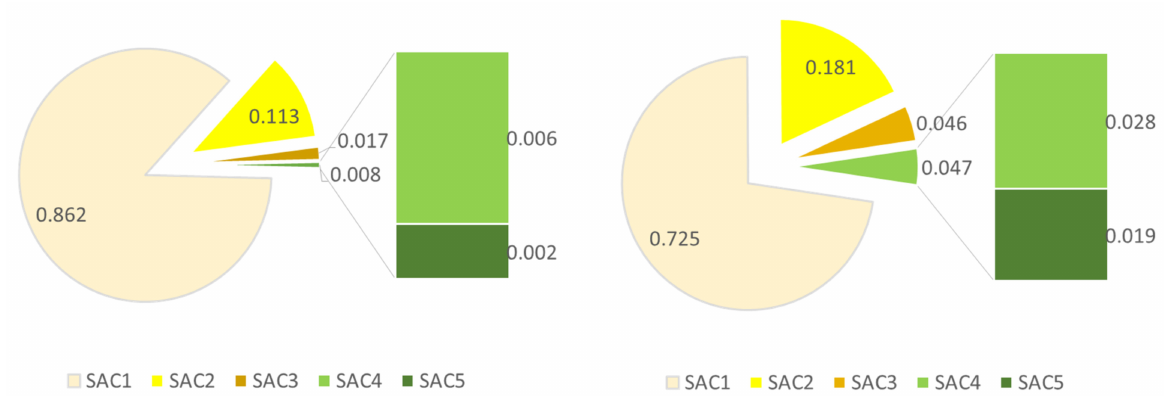
Figure 3. Distribution of slope angle classes of all parcels ( left ) and counties ( right ). Table 3. Shares of SAC in relation to the area of agricultural used land LPIS (AF) and to the total area of the county. Area Share of LPIS Area Share of County